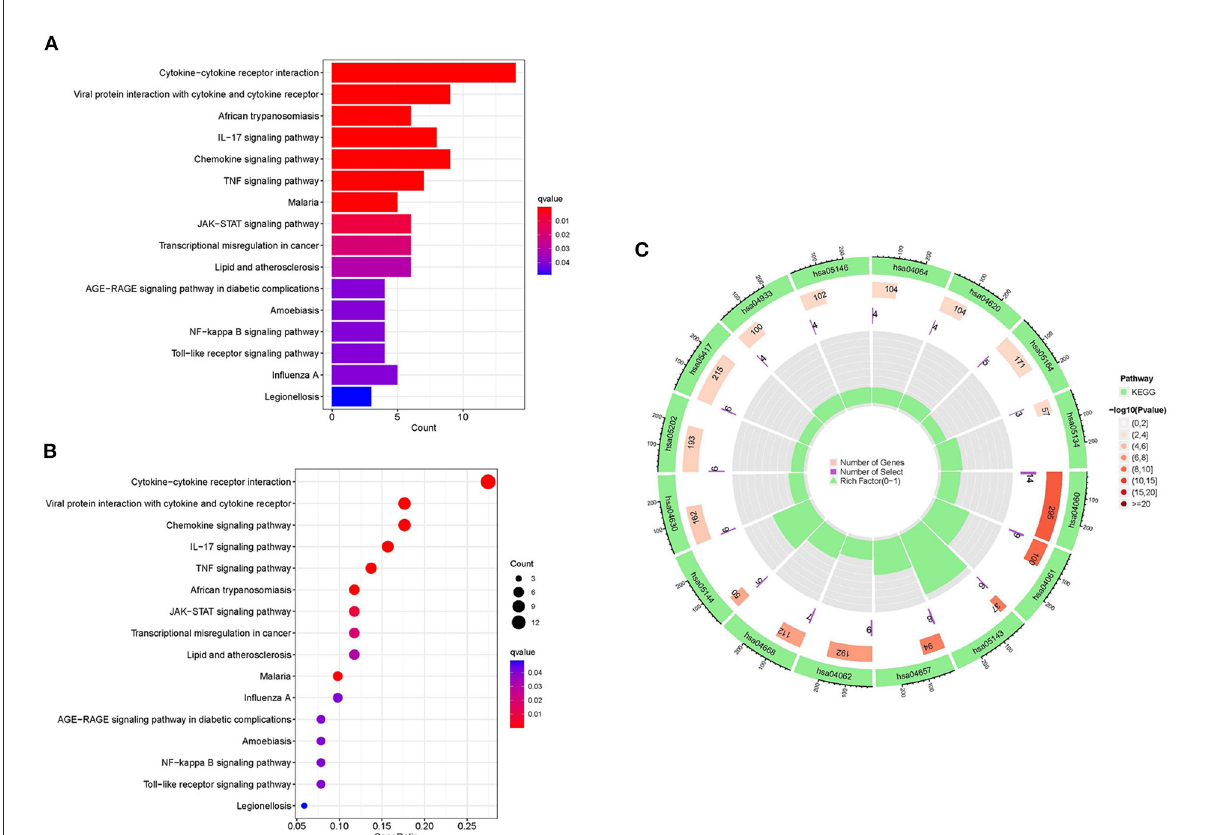
FIGURE7 KEGG enrichment analysis of DEGs. (A) The histogram of KEGG enrichment analysis; the redder the color, the more significant the enrichment. (B) Bubble diagram representing KEGG enrichment analysis; the size of bubbles indicates the number of enriched genes, and the redder the color of bubbles, the more significant the enrichment is. (C) The first circle represents the enriched KEGG:ID. The second circle represents the number of genes in different KEGG:ID pathway backgrounds, where different colors represent the significant degree of DEGs enrichment. The third circle represents the number of genes for which DEGs are enriched in the pathway. The fourth circle represents the proportion of